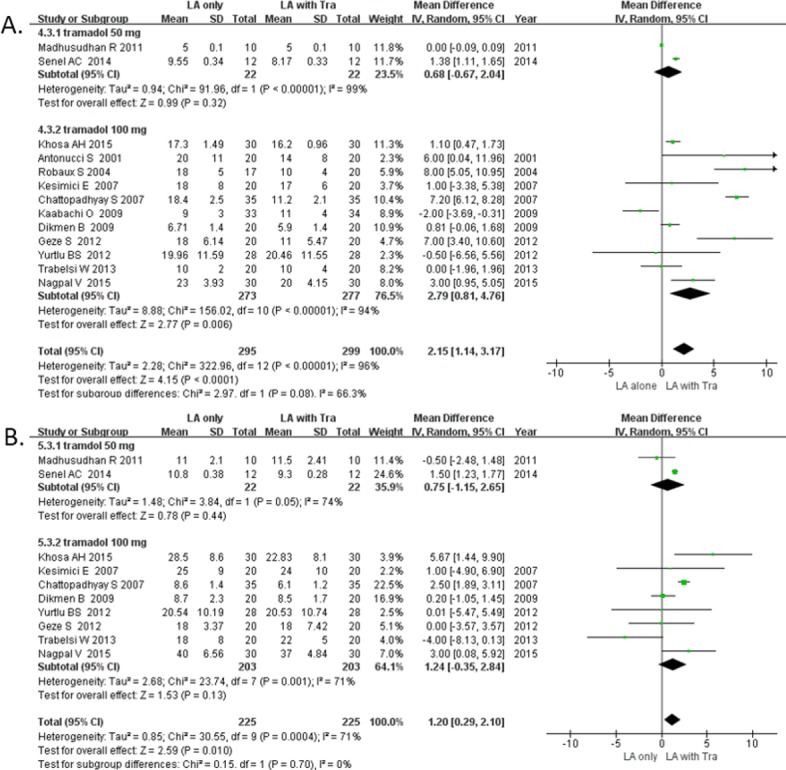
Forest plot demonstrating (A) time to onset of sensory block and (B) time to onset of motor block. Subgroup analysis by dose of tramadol. CI, confidence interval; LA, local anesthesia; SD, standard deviation; Tra, tramadol.